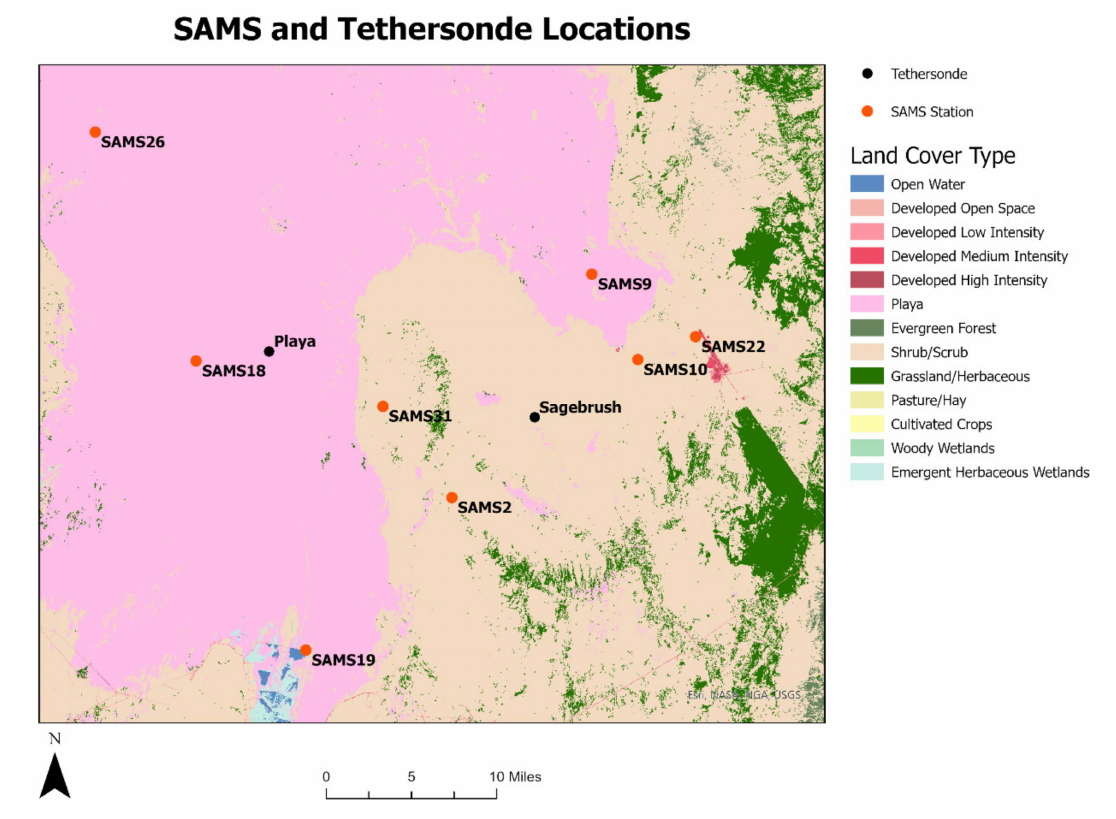
Figure 1. DPG land use with SAMS and MATERHORN tethersonde sites, along with NLCD high resolution land-cover